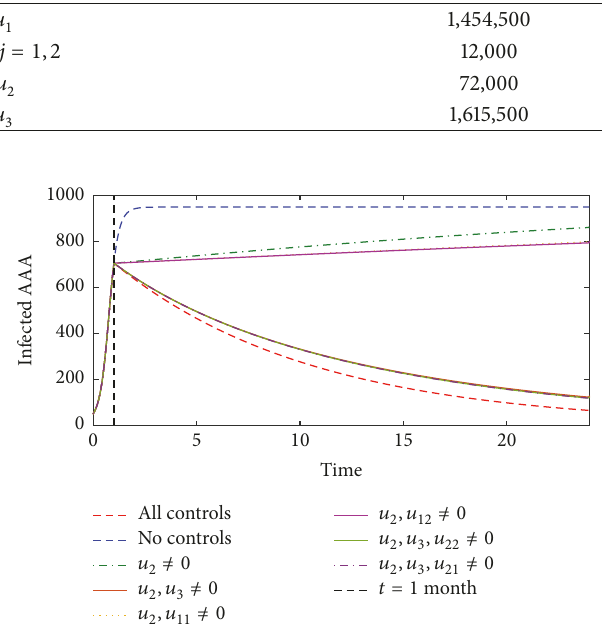
Figure 1: Simulation for the number of infected stems for AAA- genome comparing different control strategies after time 𝑡 = 1 monthappliedforaperiodof24months;(A) (𝑢 2 ̸= 0) ,(B1)( 𝑢 2 , 𝑢 12 ̸= 0 ), (B2) ( 𝑢 , 𝑢 ̸= 0 ), (B3) ( 𝑢 , 𝑢 ̸= 0 ), (C1) ( 𝑢 ,𝑢 ,𝑢 ̸= 0 ), (C2) 2 11 2 3 2 3 21 ( 𝑢 2 ,𝑢 3 , 𝑢 22 ̸= 0 ), and (D) (all